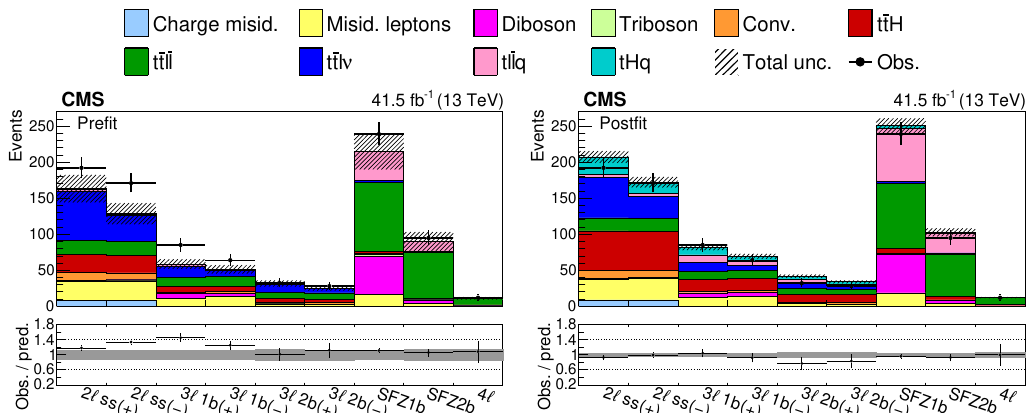
Figure 4: Expected signal category yields before (left) and after the fit procedure (right), together with the comparison to measured data [ 17 ]